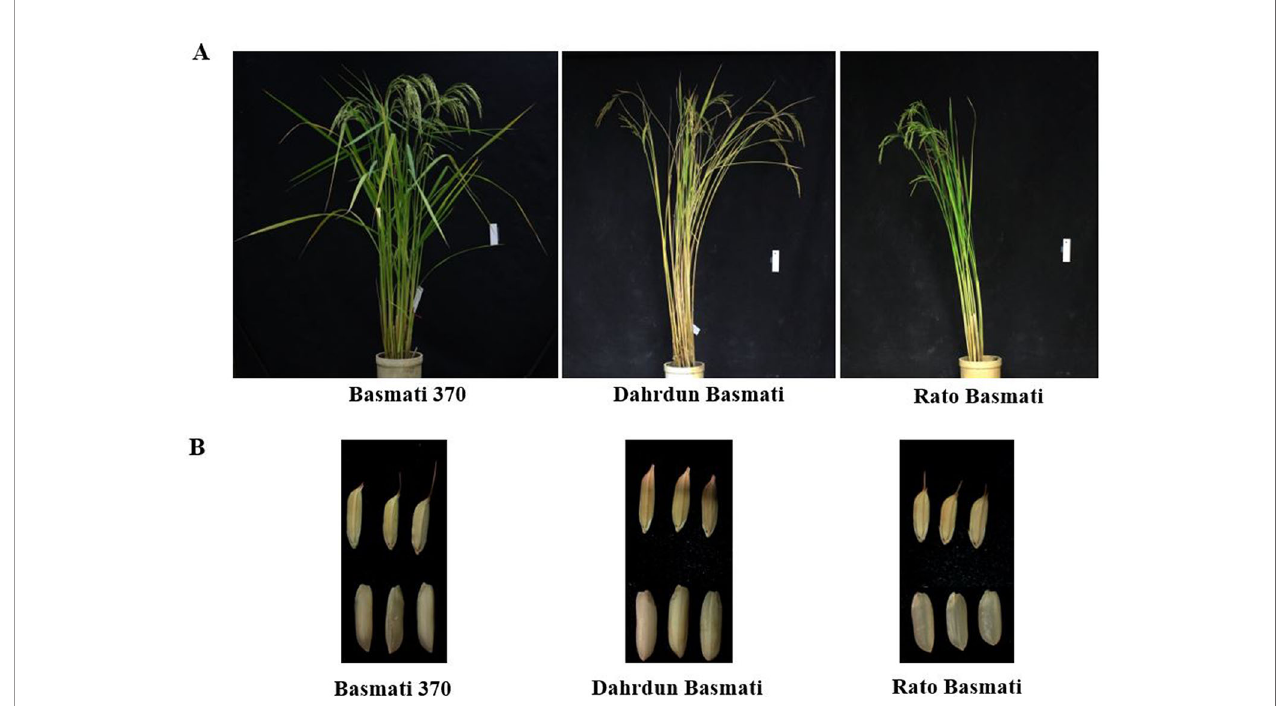
FIGURE 1 | Phenotypic comparison of Basmati 370, Dahrdun Basmati, and Rato Basmati. (A) Plant phenotype. (B) Spikelet and mature